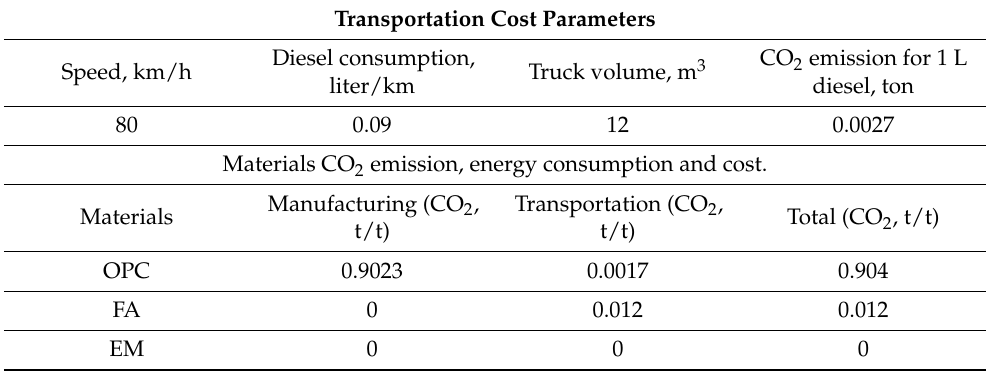
Table 6. OPC, FA and EM materials carbon dioxide emission different components of the life